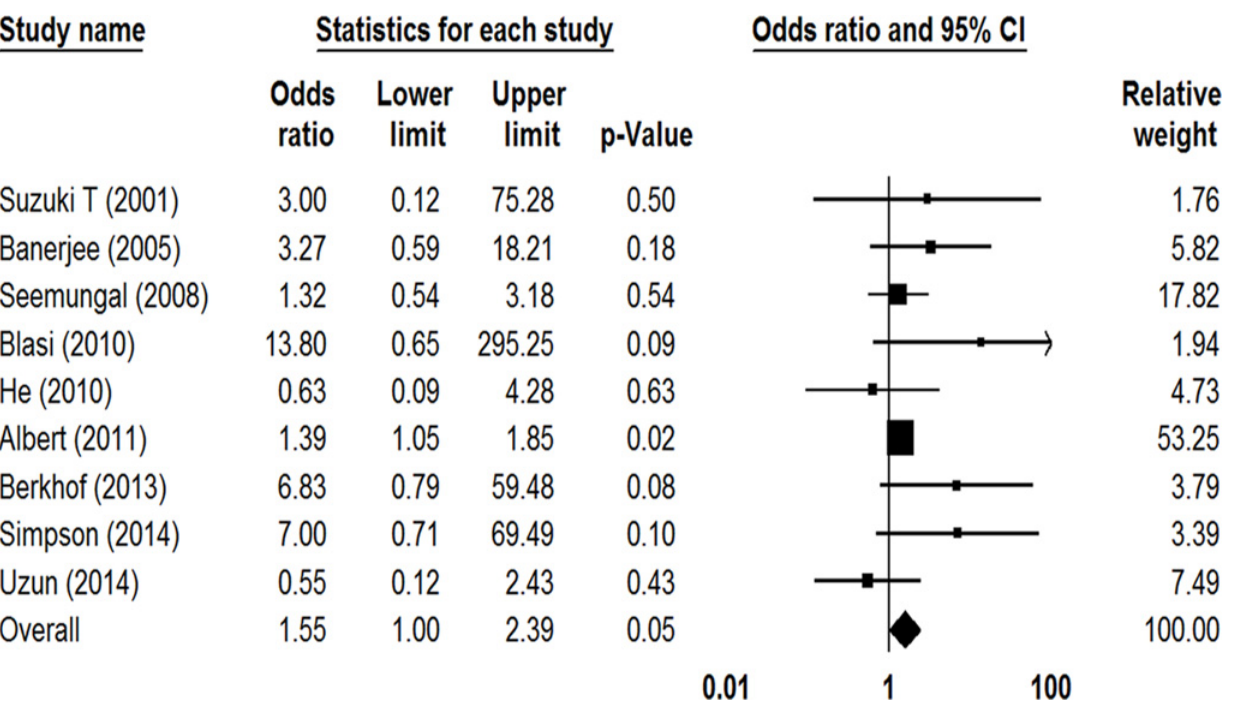
PLOS ONE | DOI:10.1371/journal.pone.0121257 March 26,